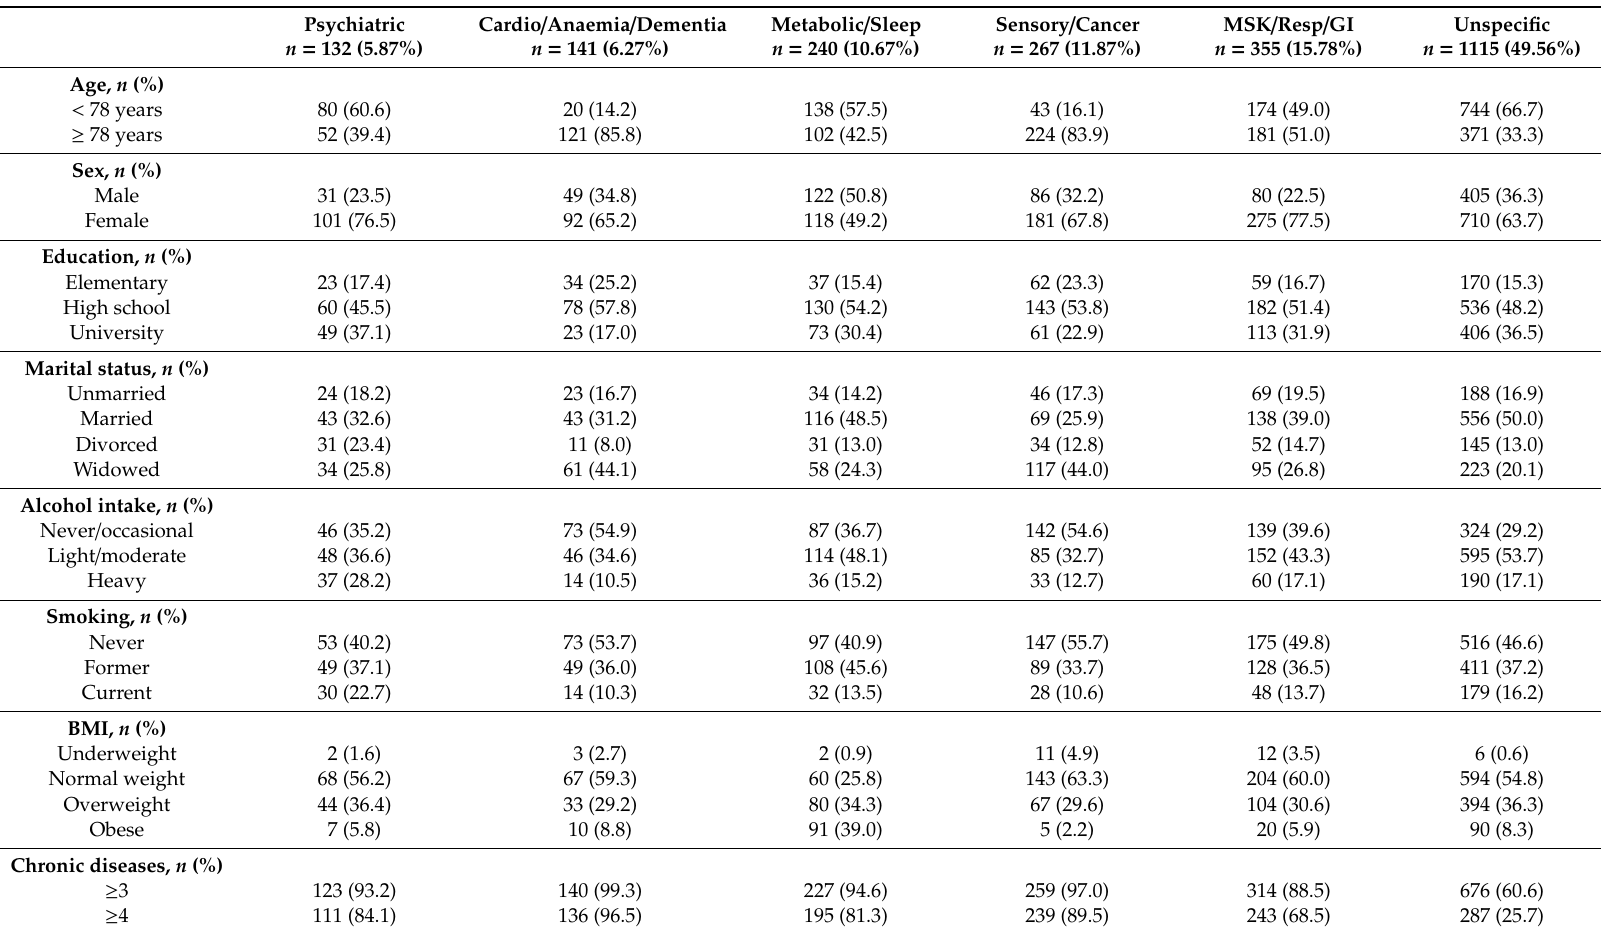
Table 1. Baseline characteristics of study participants across multimorbidity